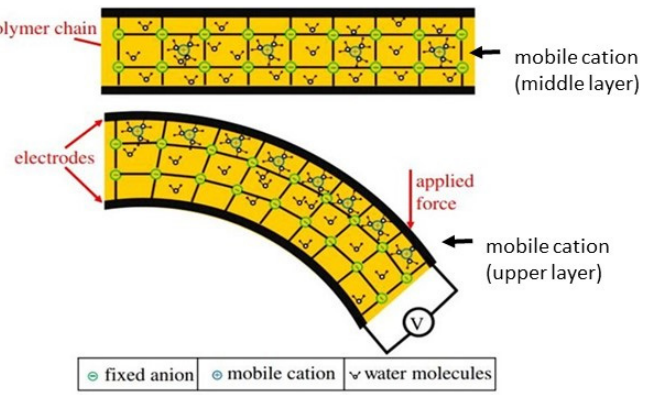
Figure 7. Schematic representation of electromechanical sensing mechanism of a typical IPMC [4]. Open access, Copyright Royal Society Publishing. Open access, Copyright Royal Society